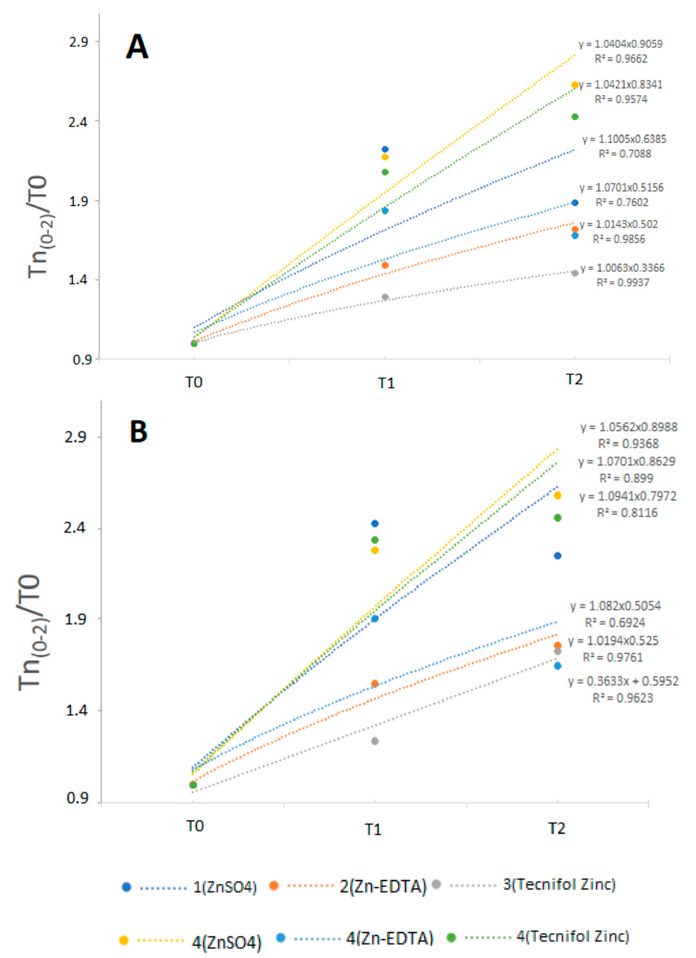
Figure 1. Ratio between the average value of Zn concentration in each treatment and the control (T0), as well as the relative trend line for all the wheat fields of Roxo ( A ) and Paiva varieties ( B ). Average values of Zn concentrations and trend lines of each wheat field are expressed in circles and lines. At harvest, Zn contents on the mature grain of both varieties in general increased as the application of Zn fertilizer had risen, being preferably located in the embryo and vascular bundle and less accumulated in aleurone (Figure 2).